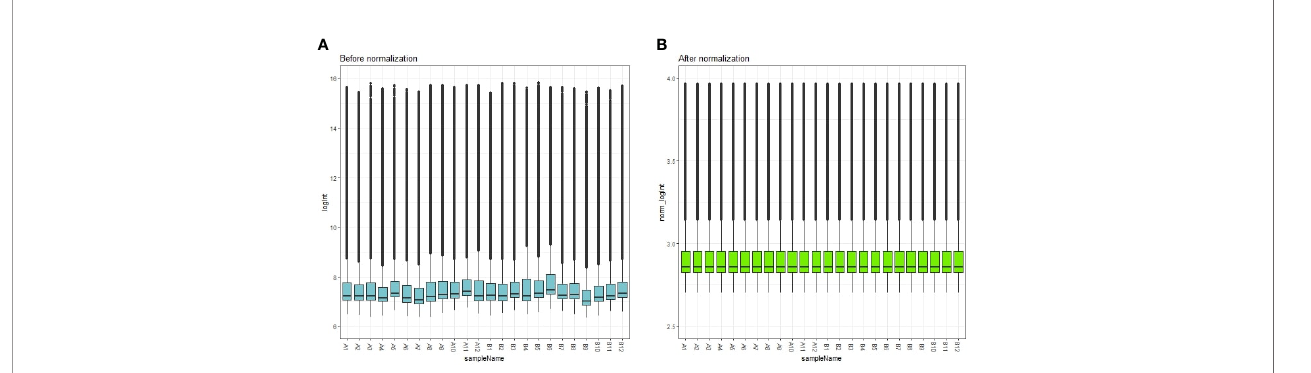
FIGURE 1 | Box plots of the gene expression data before (A) and after normalization (B) . Horizontal axis represents the sample symbol and the vertical axis represents the gene expression values. The black line in the box plot represents the median value of gene expression. (A1-A12 = adipocytes from lean persons; B1- B12 = adipocytes from obese patients).